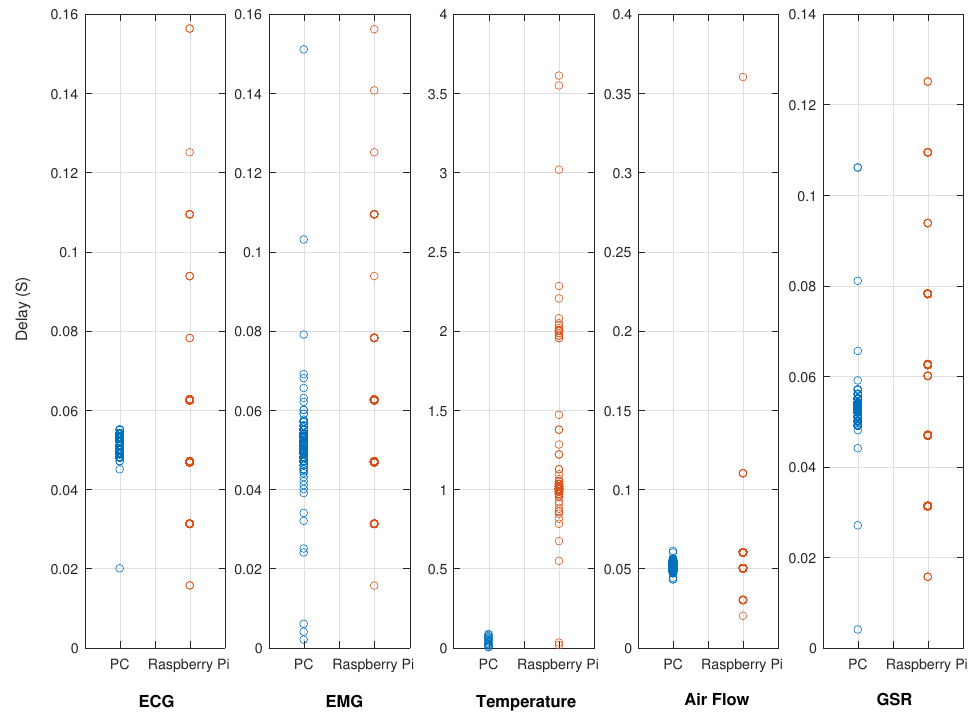
Figure 9. Comparison of the delay in the communications for the system deployed on a desktop computer and a Raspberry Pi for the segment between the Arduino and the Choreographer for the active communication